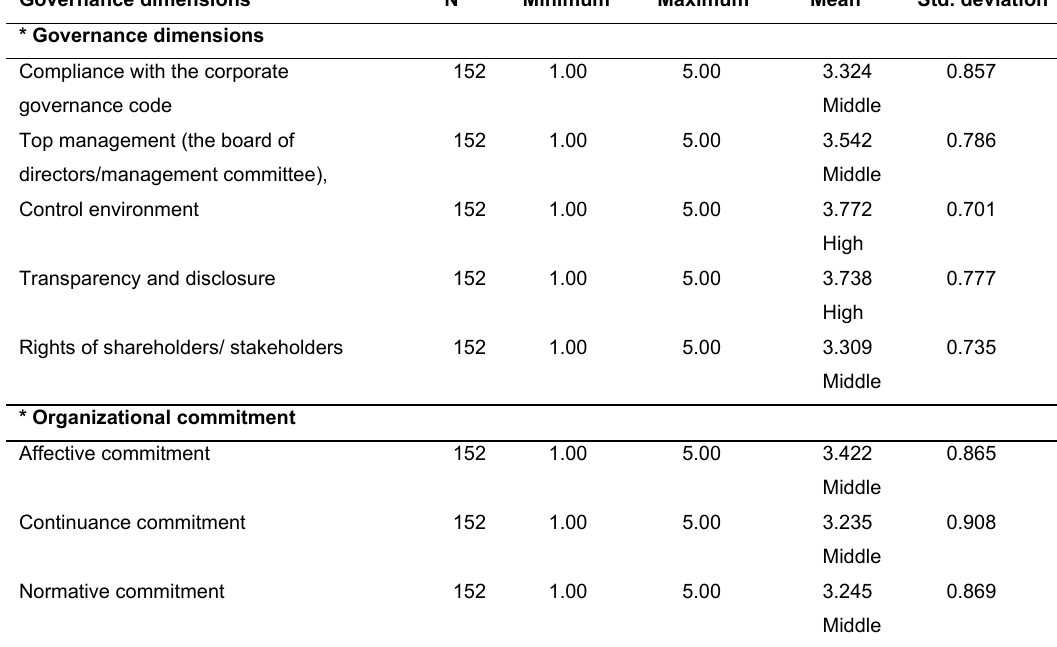
Table 4. Descriptive